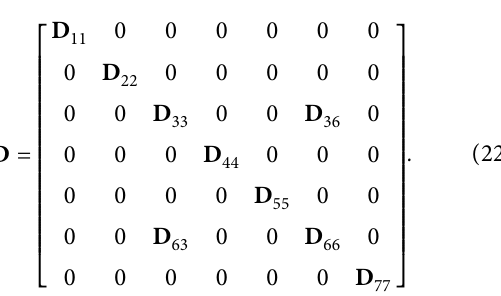
Figure 2: Block diagram of the open loop